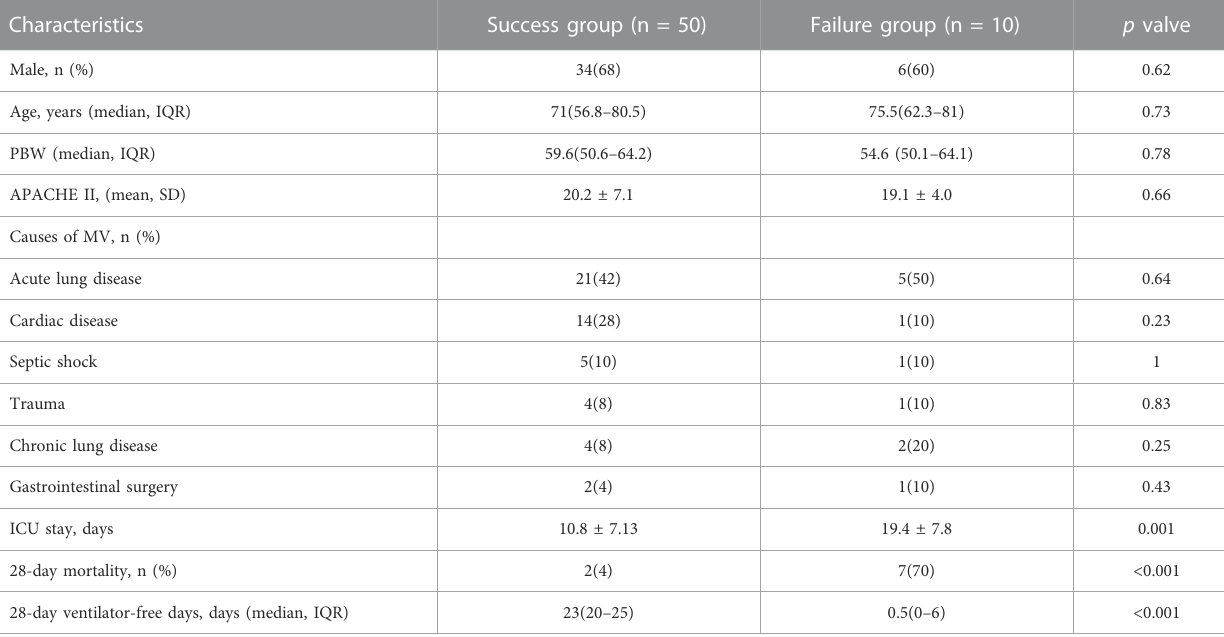
TABLE 1 Clinical characteristics and outcomes of patients.